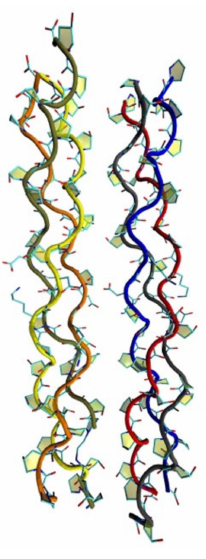
Figure 10. Tropocollagen